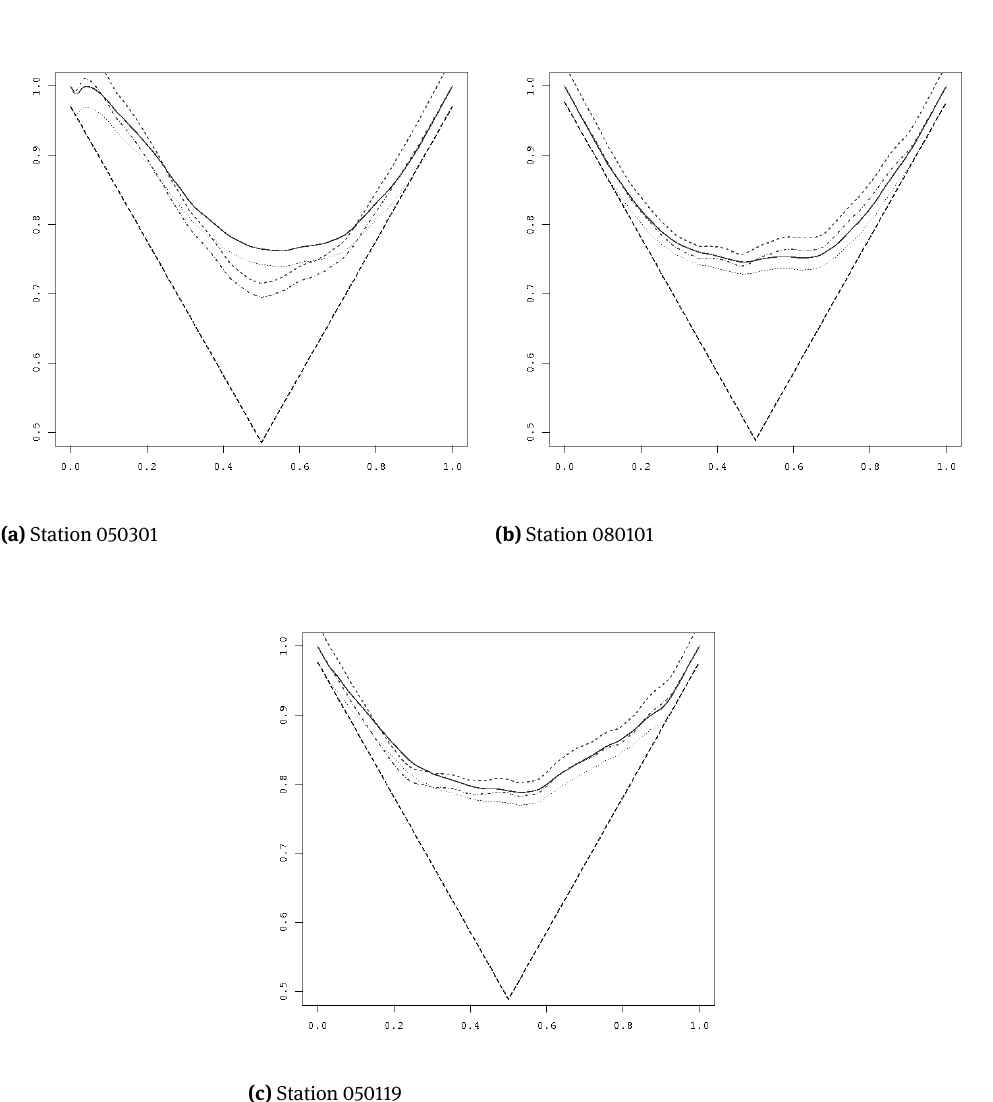
Figure 6: Estimators of the Pickands dependence function A ( t ) for t ∈ [0, 1] : corrected endpoint estimators ˆ A P n , c ( t ) (- · - · -), ˆ A CFG ( t ) (—) and rank-based estimators ˆ A P ( t ) (- - - -) and ˆ A CFG ( t ) (...). n , c n , r n , r distribution and especially by the Gumbel-Hougaard family copula since pv .jac, pv .fsa, pv .asy, pv .ky, pv .mpl and pv .itau are lower than